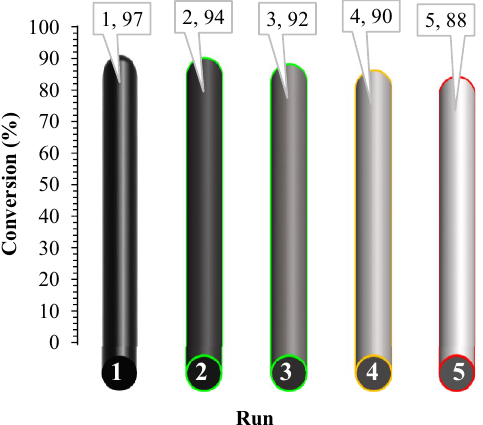
Figure 11. Recycling potential of Fe 3 O 4 @Pectin@(CH 2 ) 3 -Acetamide-Cu(II).